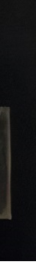
Figure 2. Tooth fixed on